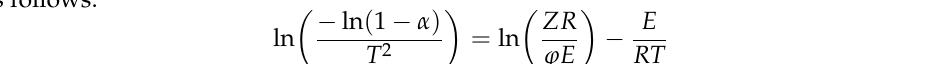
Table 1. Kinetic and thermodynamic parameters data of PMMA-perylene dye (I), PMMA-perylene-PA (II), and PMMA-perylene-CLA (III) polymer sheets. Parameter rE Compounds